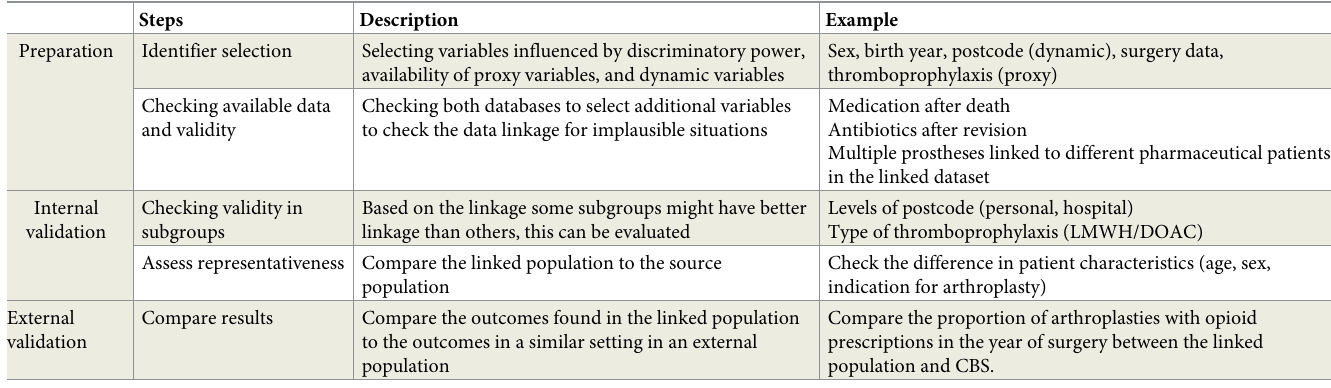
Table 1. Overview of different steps to accomplish the data linkage.